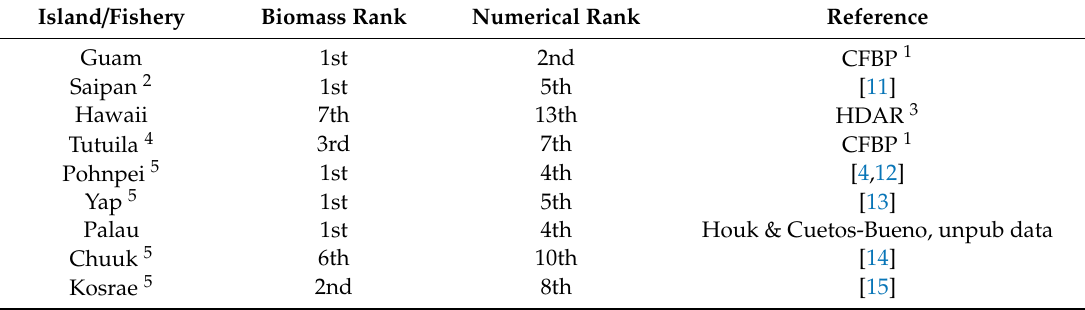
Table 1. Summary of rankings for Naso unicornis (by harvested mass and number of harvested individuals) in reef-associated commercial and artisanal fisheries of United States-a ffi liated Pacific Islands and Micronesian islands for which long-term (generally > 1 year) and high-frequency data were